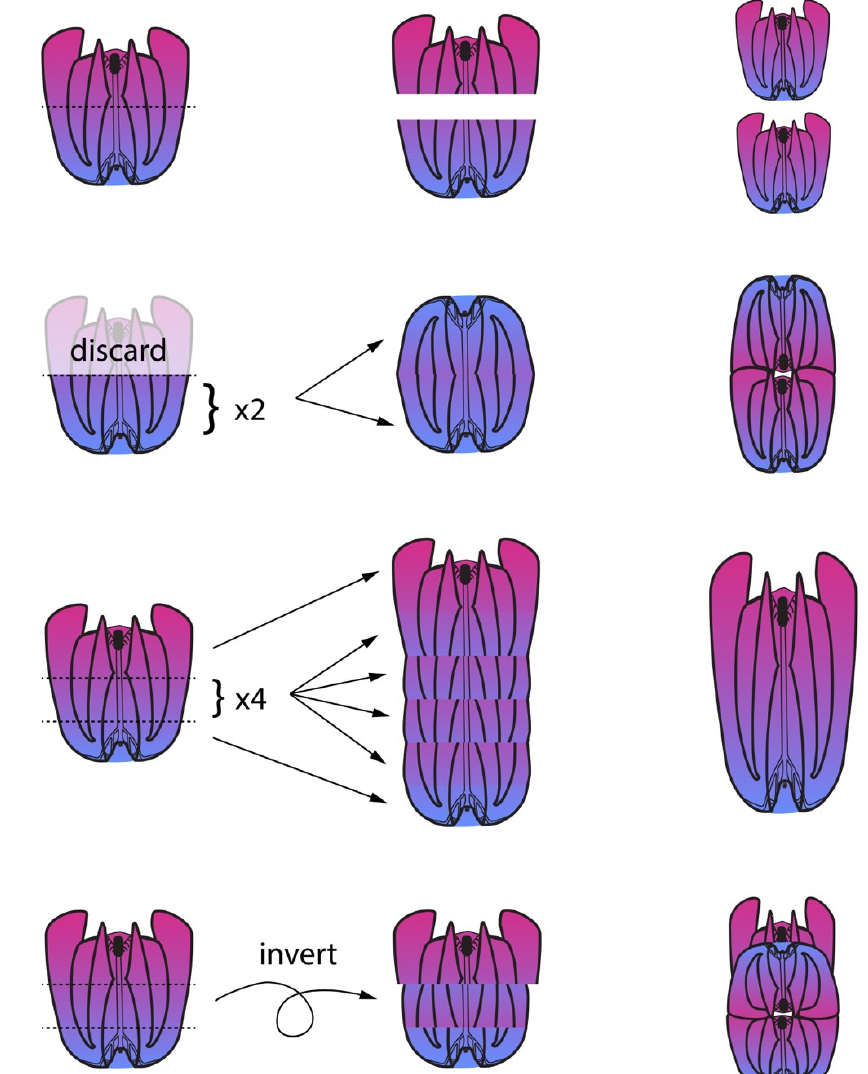
Figure 4. Cut-and-paste grafting experiments by Coonfield show that the oral–aboral axis is stably determined in adult ctenophores. Top row : animals bisected equatorially regenerate into two normally patterned animals. Second row : when two aboral halves are grafted together, both retain their original polarity. Each half grows new oral tissues such as mouth and lobes and the animals are fused at the oral region. Third row : when animals are cut into thirds and a series of middle pieces from different animals (four individuals in this case) are grafted in their native orientation with one apical and one oral piece, the animal regenerates to have a single common oral–aboral axis. Fourth row : when animals are cut into thirds and the middle piece is inverted on the oral–aboral axis, all three pieces maintain their original polarity (although the oral piece may not regenerate a new apical